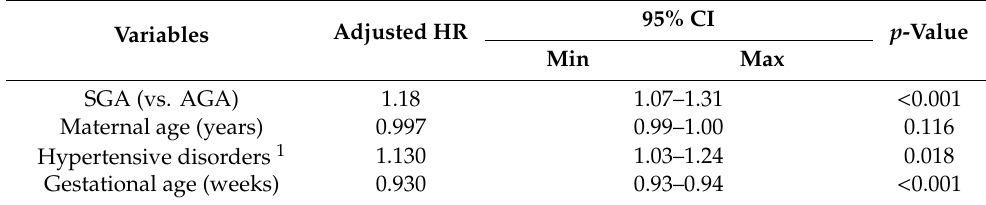
Table 3. Cox multivariable regression model for the risk of long-term neurological morbidity of the o ff